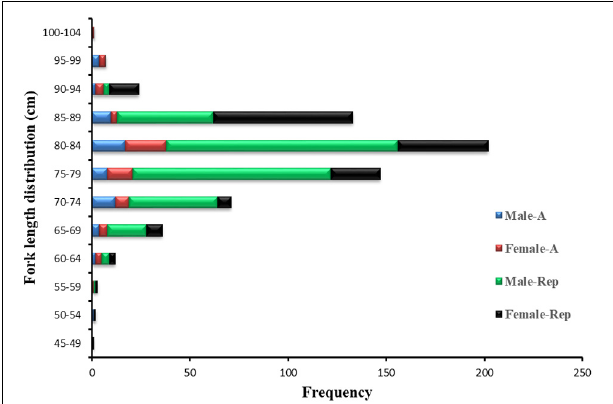
FIGURE 2 | Length frequencies of male and female P. kamoharai specimens captured between November 2012 and May 2020. Blue bars represent male specimens for age study; Red bars, female specimens for age stu dy; Green bars, male specimens for reproduction study; Black bars, female specimens for reproduction